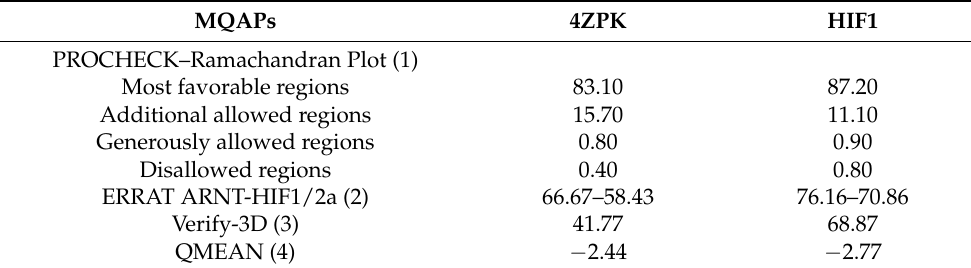
Table 1. Quality assessment of the HIF1 model compared to template.